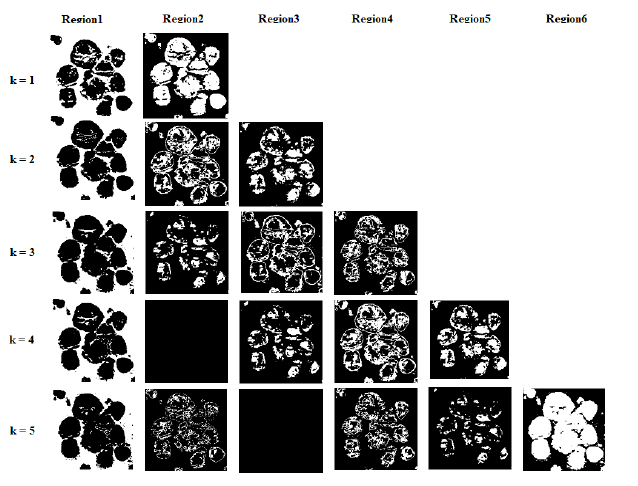
Figure 6. The output images of the MMPSO segmentation algorithm when the number of thresholds is varied as 1, 2, 3, 4, and